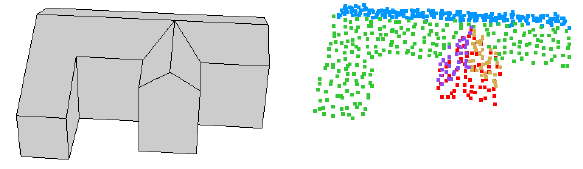
Figure 4. Result of the subsurface segmentation. Virtual points are colorized in red.